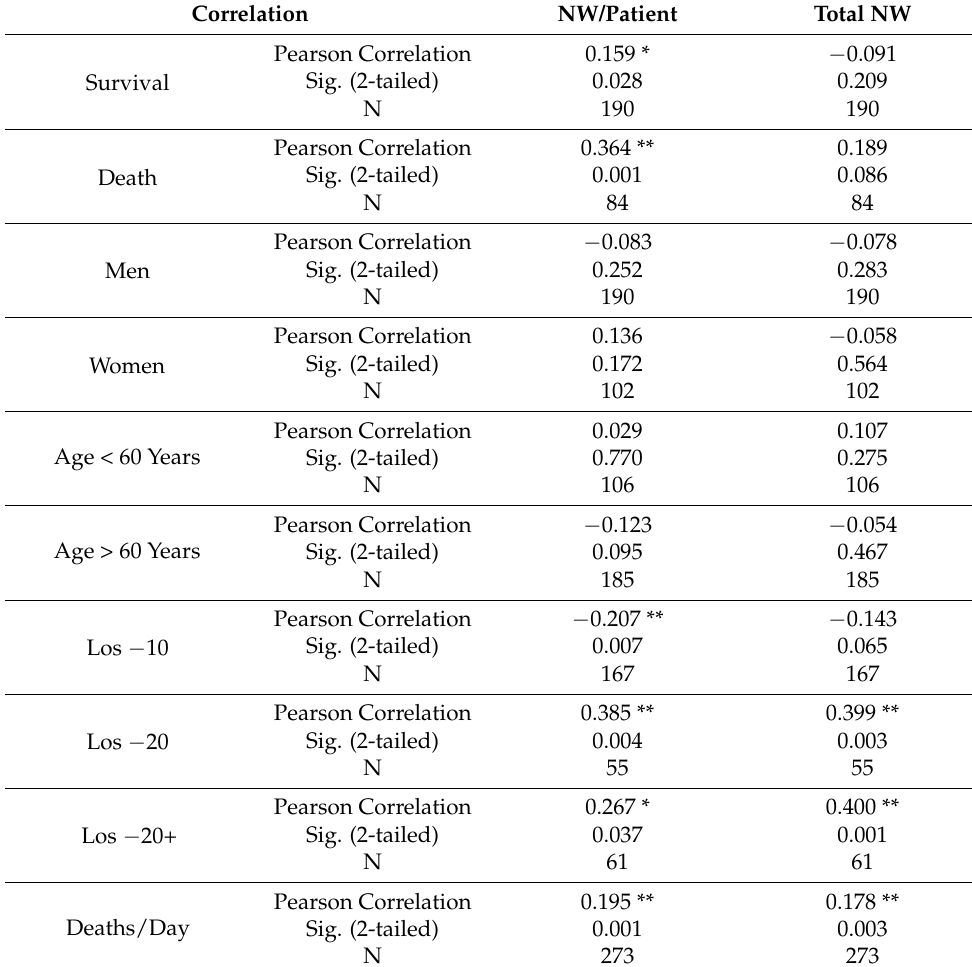
Table 7. Correlation between NW and ICU patients’ data.